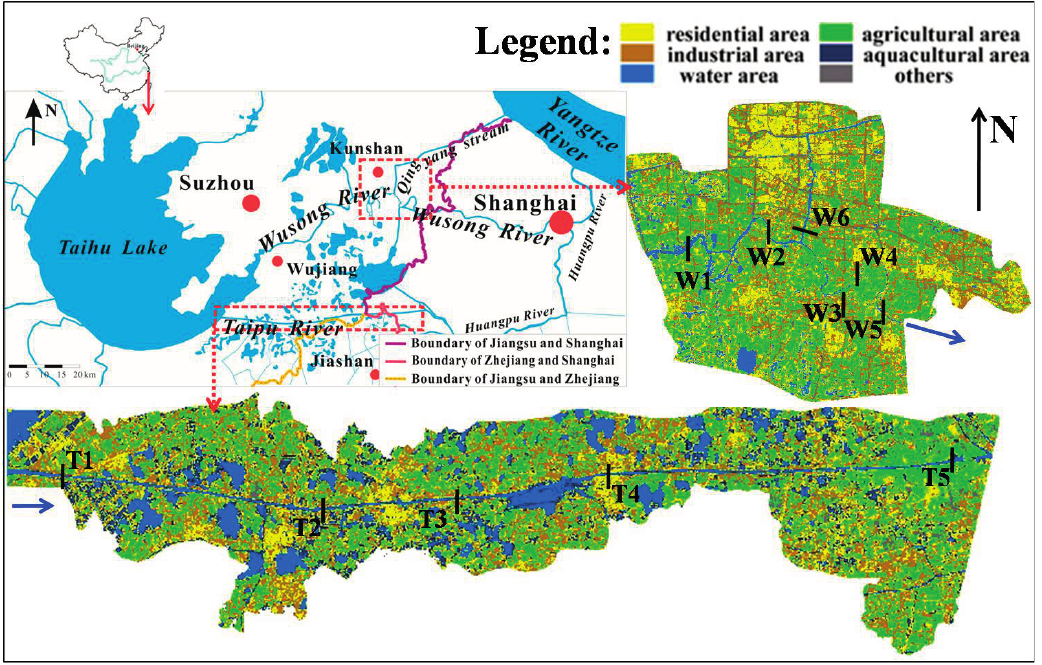
Figure1. Locations of the study area and observed